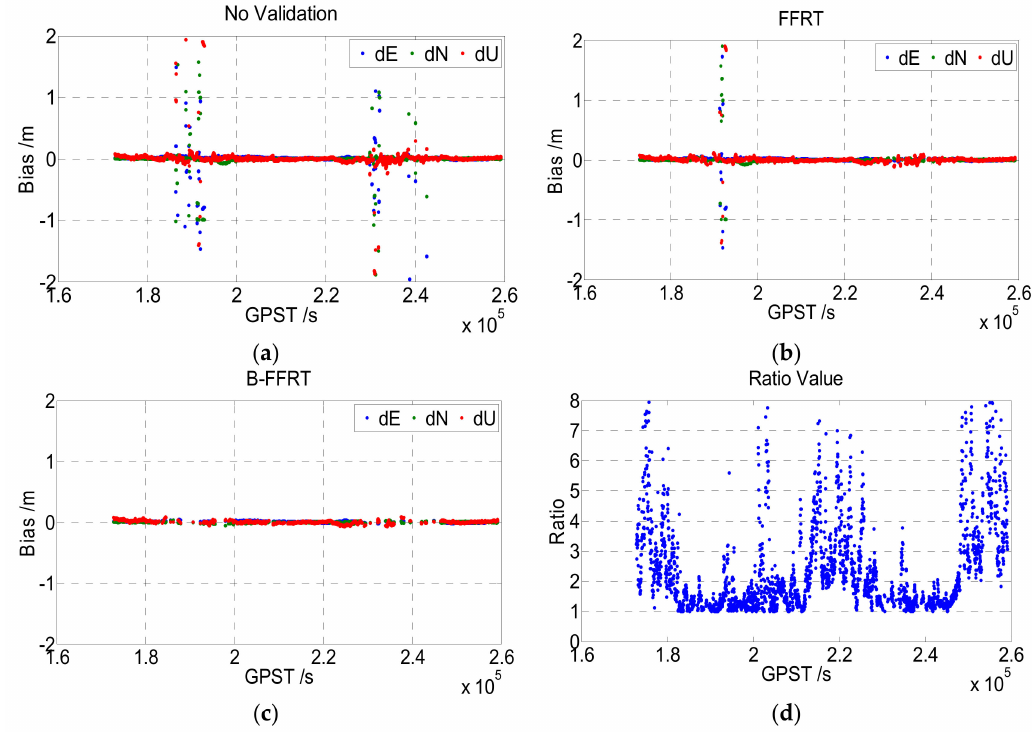
Figure 3. Baseline bias obtained by No-Validation ( a ), FFRT ( b ), B-FFRT ( c ) respectively, and the ratio value ( d ) of it.